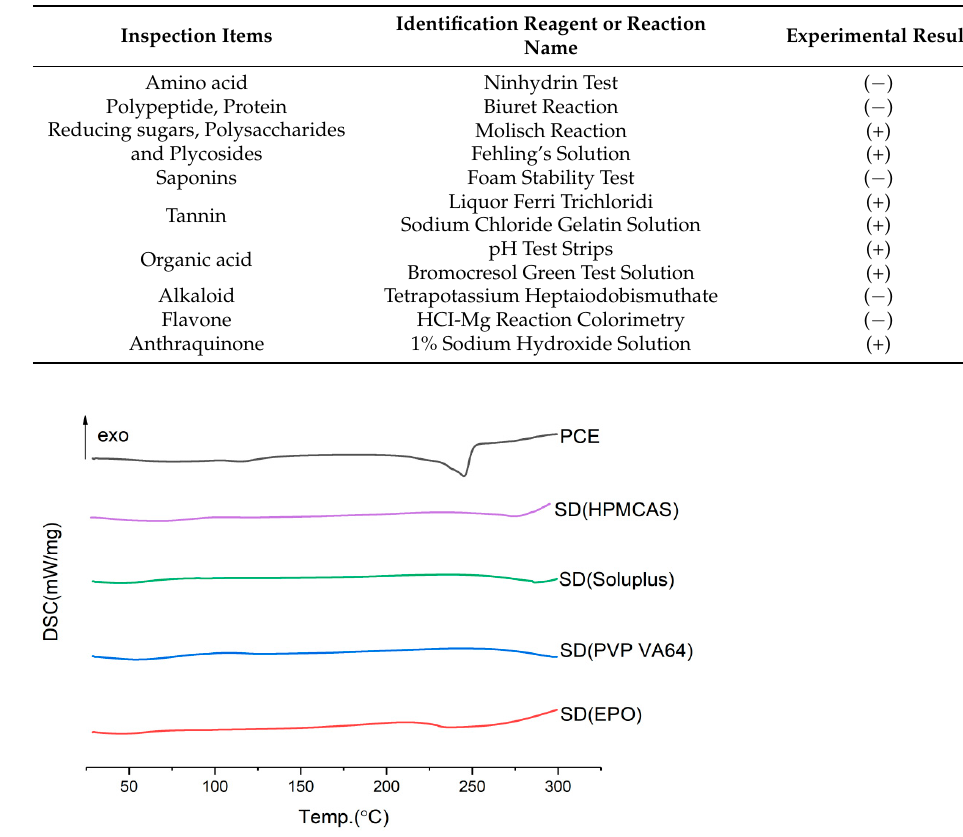
Figure 1. DSC diagram of solid dispersion prepared by different carrier.